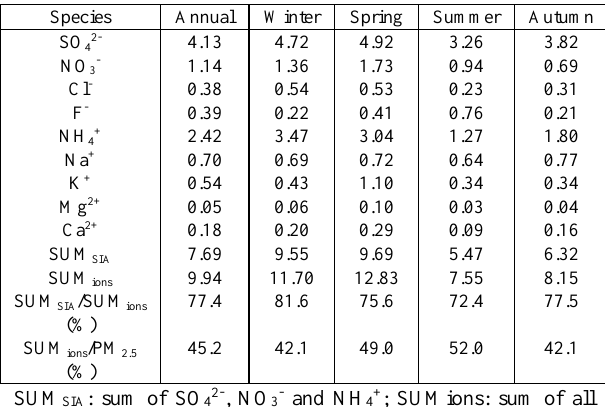
Table 2. Annual and seasonal mean concentrations of